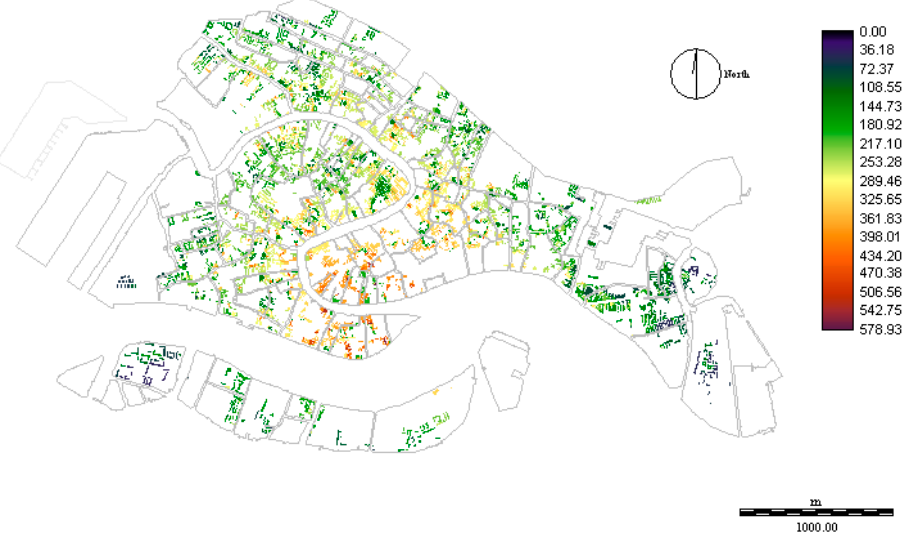
Figure 9. Average value increments of eliminating high water for upper stories. Table 7. Average value increments for the Sestiere ( € m − 2 Value increments were higher in the Sestieri of S. Polo, S. Marco, S. Croce, and Dorsoduro, whereas minor increments were registered in Castello and Giudecca due to lower real estate value.